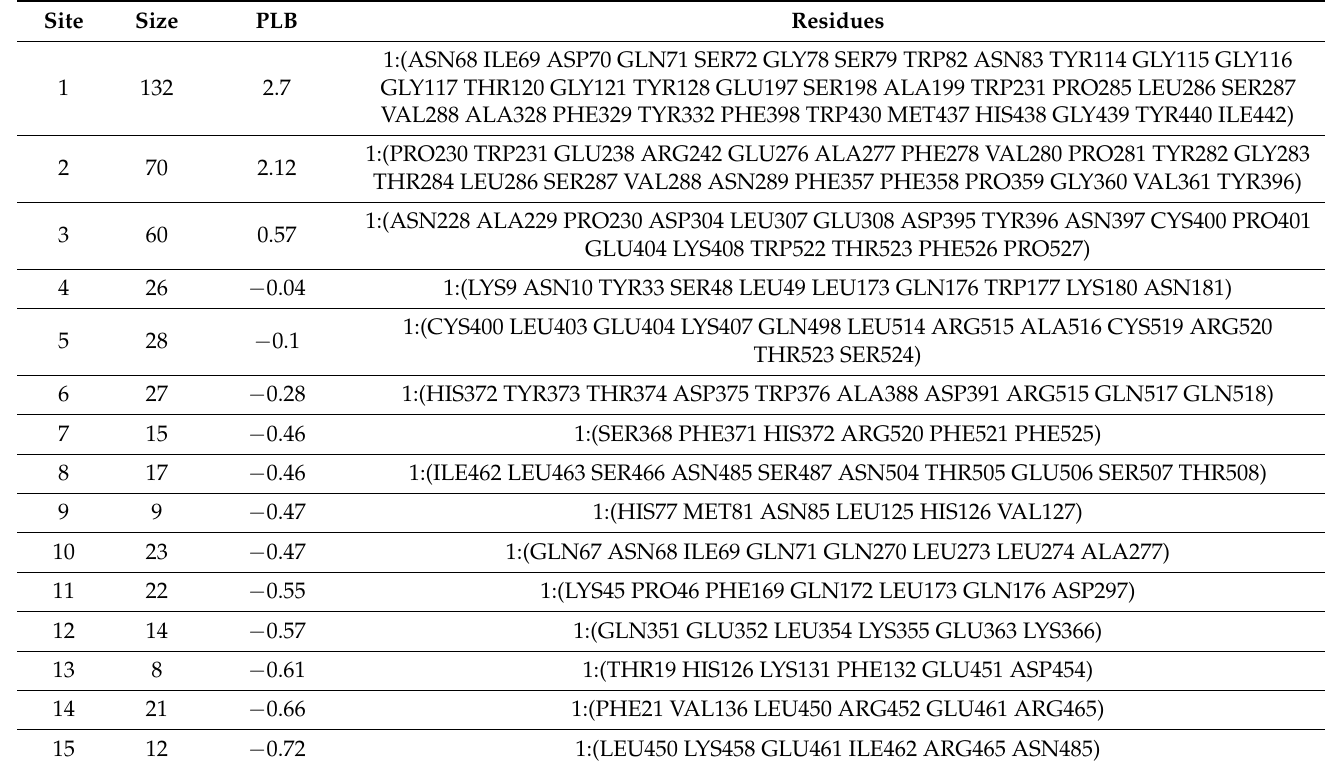
Table 8. Predicted binding sites for